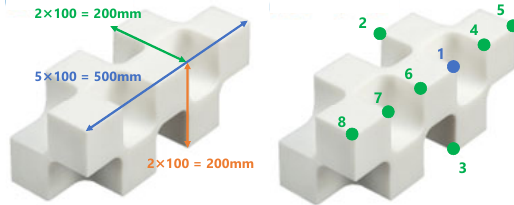
Figure 13. Target object for evaluation